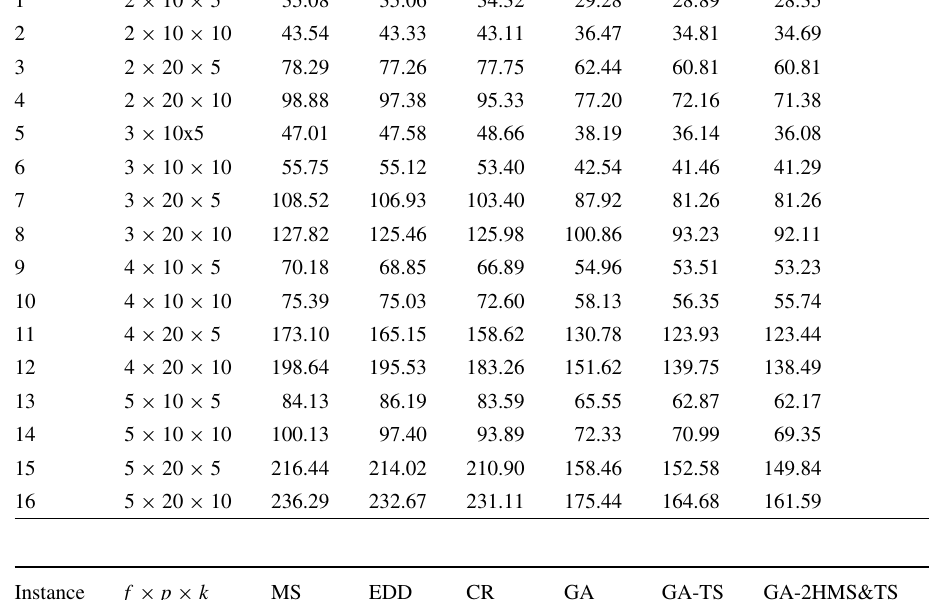
Table 6 Results with different algorithms for large sized